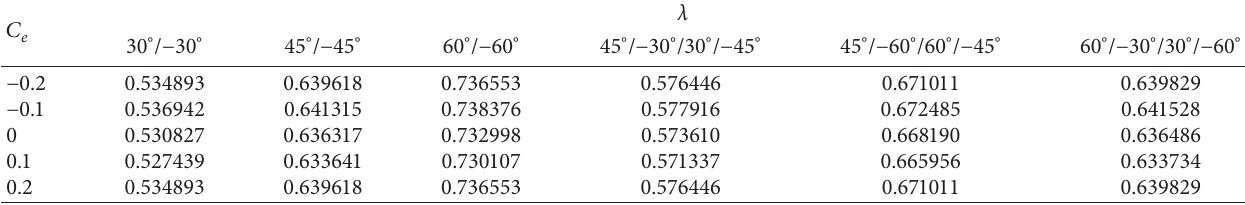
Table 5: Fundamental frequency parameter value with exponential variation in thickness for different stacking sequences. C e